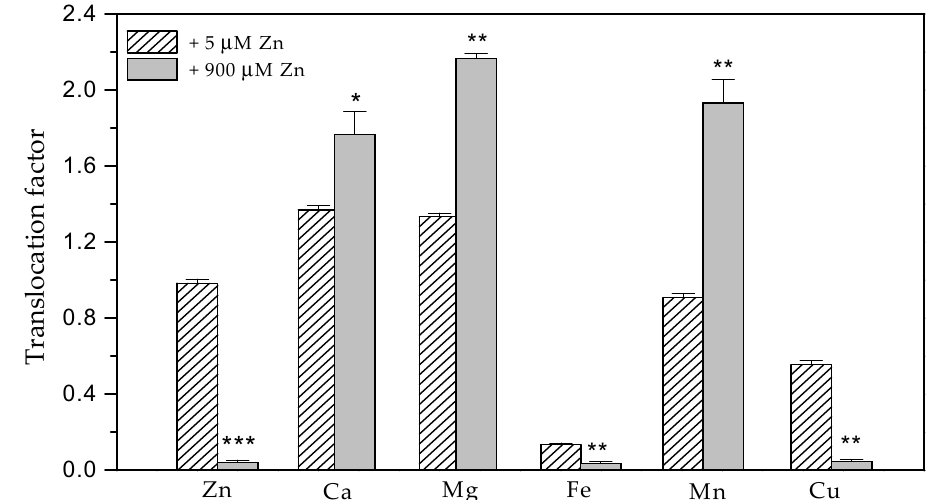
Figure 3. Changes in the translocation factors of the elements in Salvia sclarea plants in response to 5 µ M (control) or 900 µ M (excess) Zn exposure for 8 days. Mean values ( ± SE) were compared between the two Zn exposures for the same elements using a Student’s t -test, and the differences were considered statistically significant with * p < 0.05, ** p < 0.01 and *** p < 0.001.